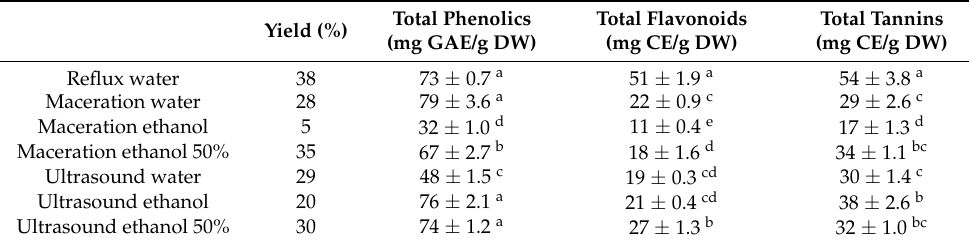
Table 2. Mean values of Yield, total phenolic, tannin, and flavonoid contents of A. unedo leaves extracts from different extraction methods (mean ± standard deviation, n =